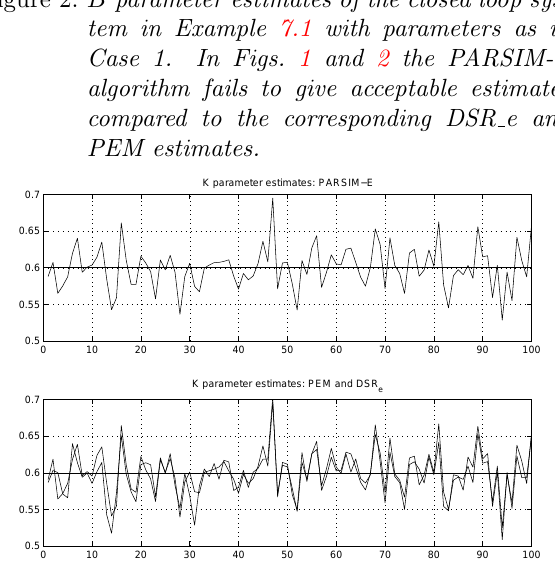
Figure 3: K parameter estimates of the closed loop sys- tem in Example 7.1 with parameters as in Case 1. Here the PARSIM-E algorithm gives acceptable estimates compared to the corre- sponding DSR e and PEM